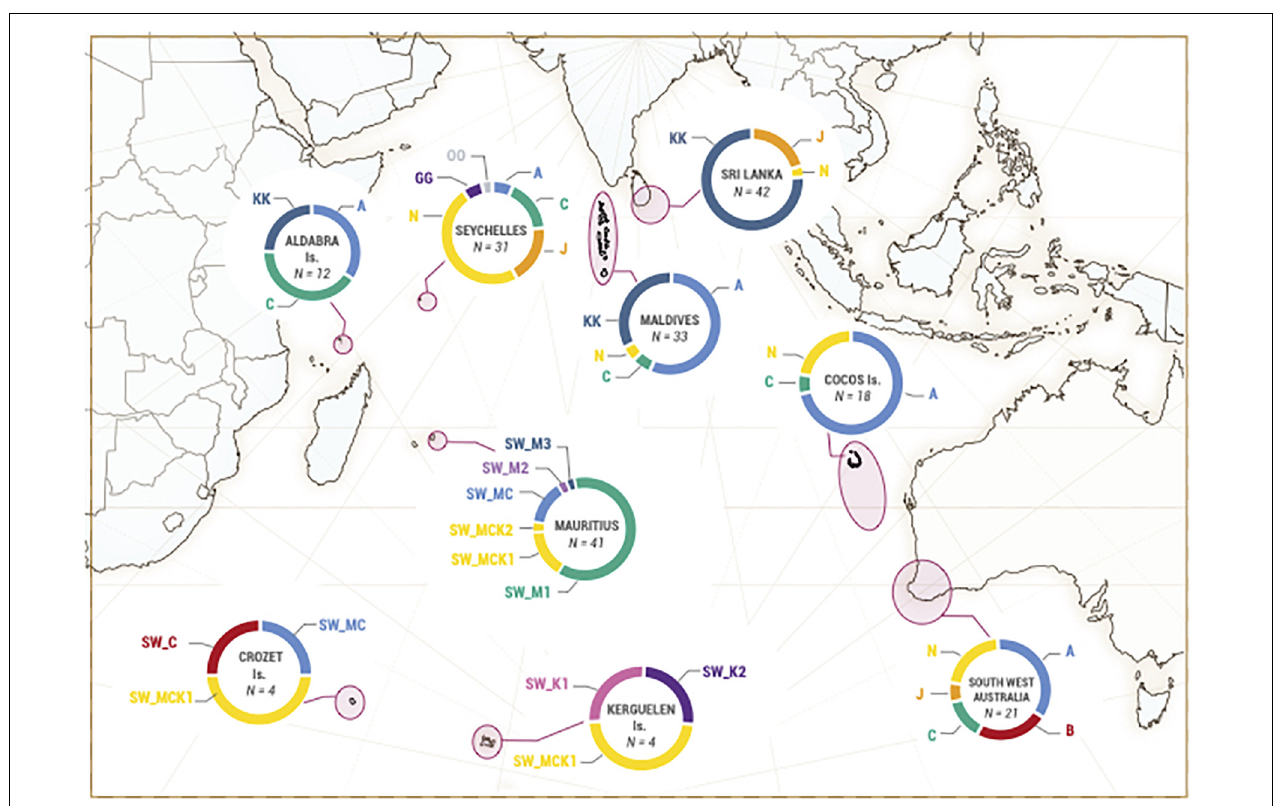
FIGURE 2 | Geographical partitioning of mitochondrial haplotypes in the Indian Ocean determined by Alexander et al. (2016) (haplotypes named with one or two letters) and haplotypes determined during this study (haplotype names starting by SW). Identical colors indicate corresponding haplotypes (602 bp in common, see Supplementary Table 5 for correspondence of haplotype names). N: number of sperm whales for each